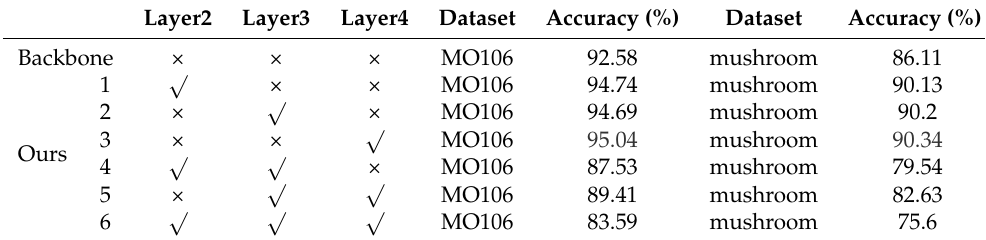
Table 3. The effect of Multidimension Attention on the model at different locations.